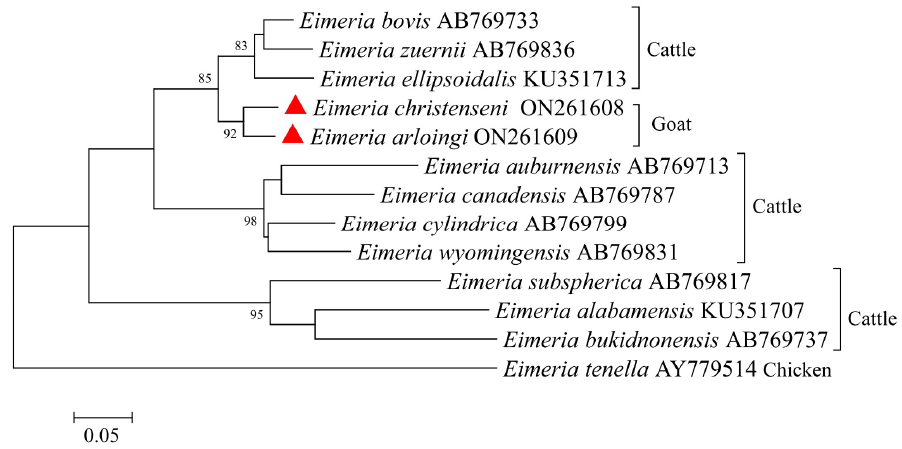
Figure 4. Phylogenetic tree generated by the Neighbor-Joining method using full sequences of the ITS-2 region of E. christenseni and E. arloingi from the present study and representative sequences of other Eimeria species available in GenBank. The sequences obtained in this study are marked with red triangles (bootstrap values below 75% are not indicated).